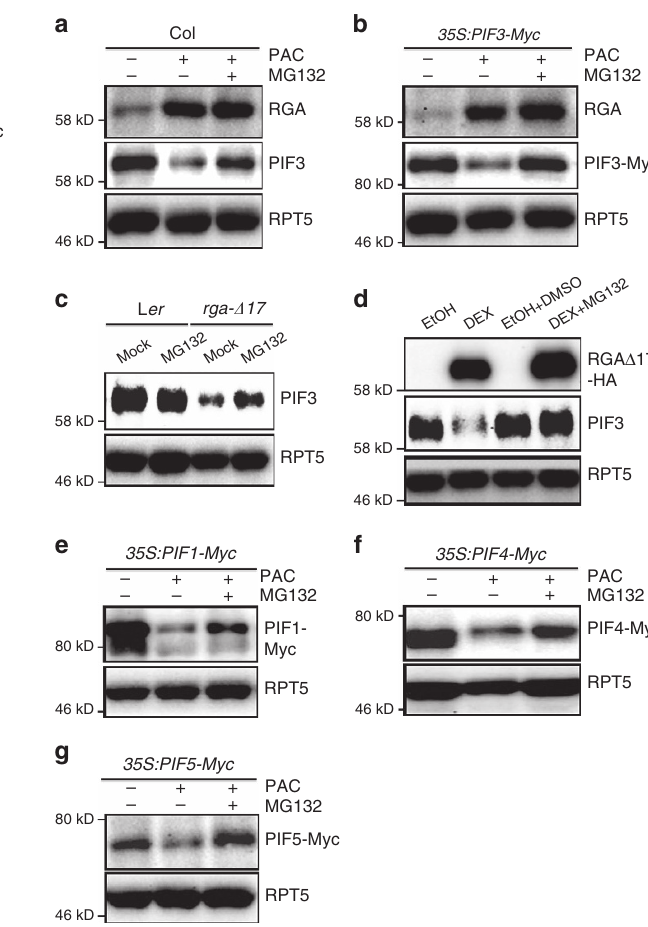
Figure 5 | DELLAs promote the degradation of PIF proteins via the ubiquitin–proteasome system. ( a , b ) Effects of PAC (0.5 m M) and MG132 (100 m M) treatments on RGA, PIF3 and PIF3-Myc protein levels in 4-day-old dark-grown seedlings. ( c ) Effects of MG132 on PIF3 protein levels in 4-day-old dark-grown rga- D 17 seedlings. ( d ) Effects of MG132 on PIF3 protein levels after transient induction of RGA D 17-HA. Four-day-old dark- grown RGA D 17-HA seedlings were treated with DEX or DEX plus MG132 for 24h. EtOH and DMSO are the solvents for DEX and MG132, respectively. ( e–g ) Effects of combinational PAC and MG132 treatments on PIF1-Myc, PIF4-Myc and PIF5-Myc protein levels in 4-day-old dark-grown seedlings. Each immunoblot result is the representative of at least three repeats, and RPT5 was used as a loading